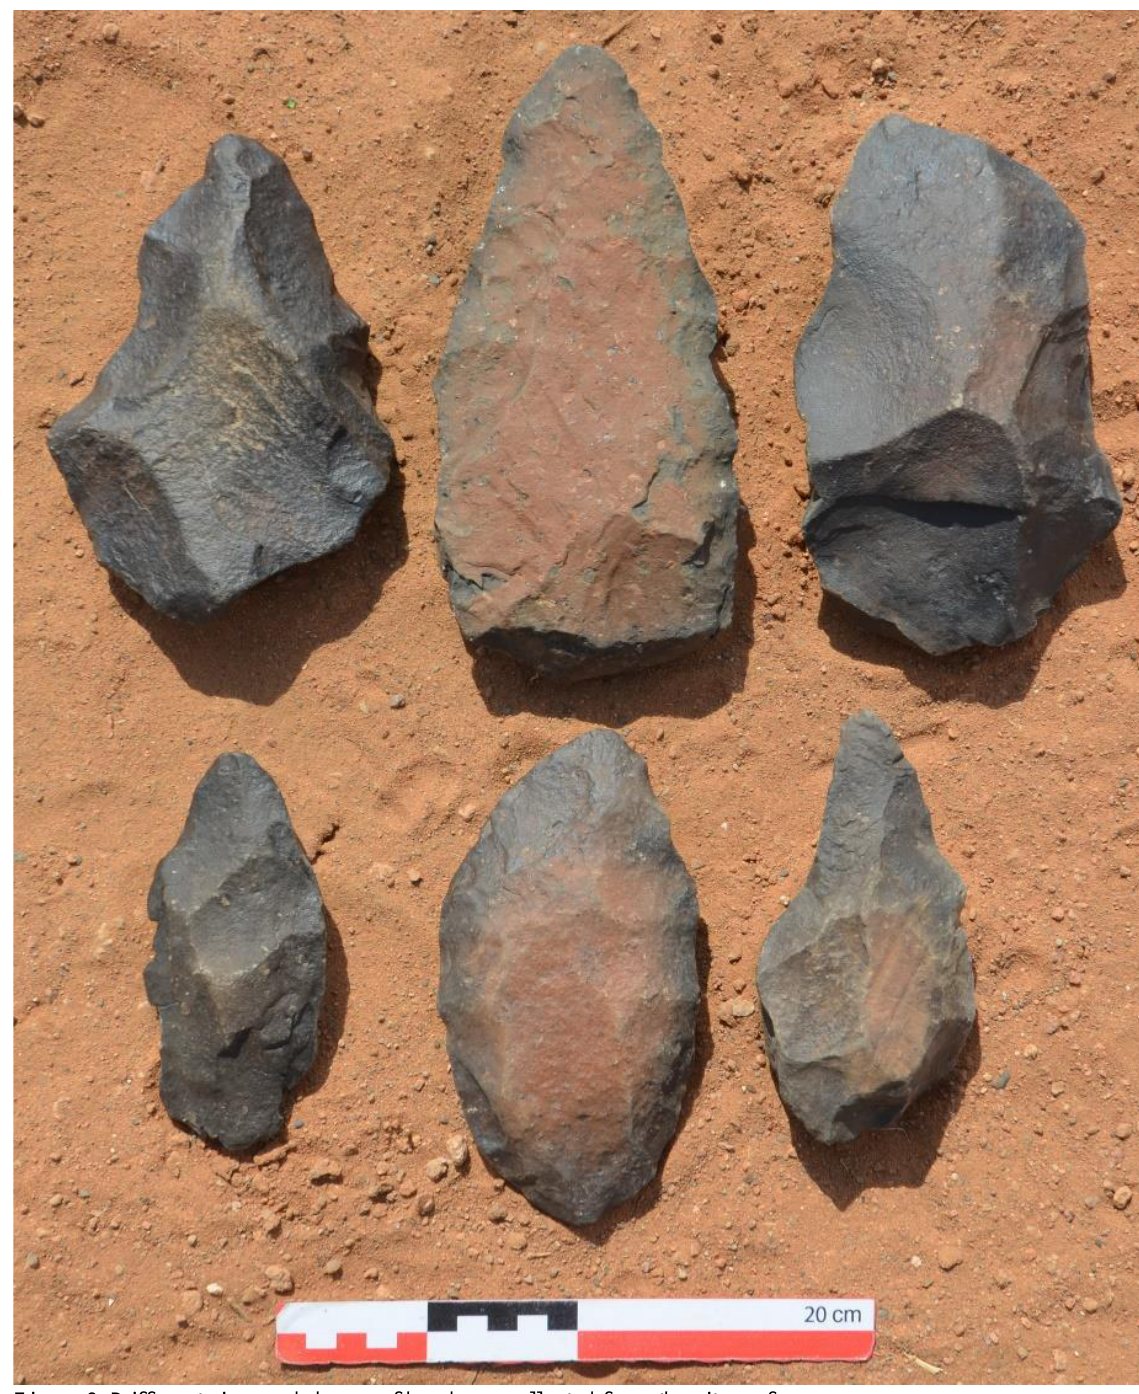
Figure 6: Different sizes and shapes of handaxes collected from the site